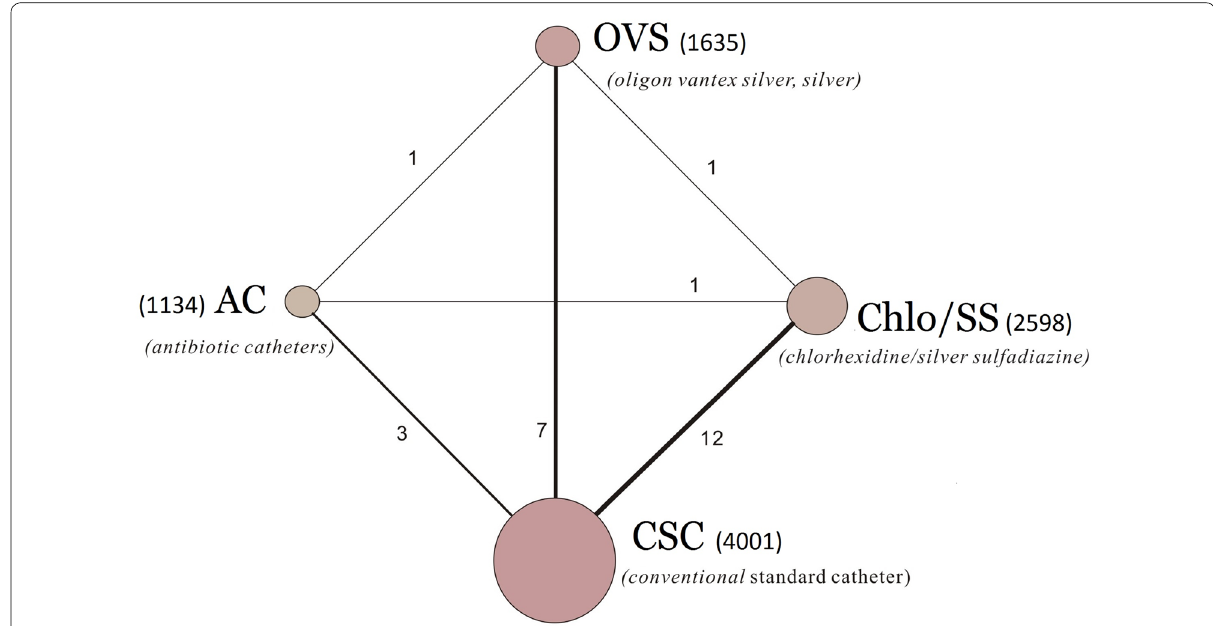
Fig. 3 25 RCTs reported information on the rate of CRBSIs per 1000 central line-days